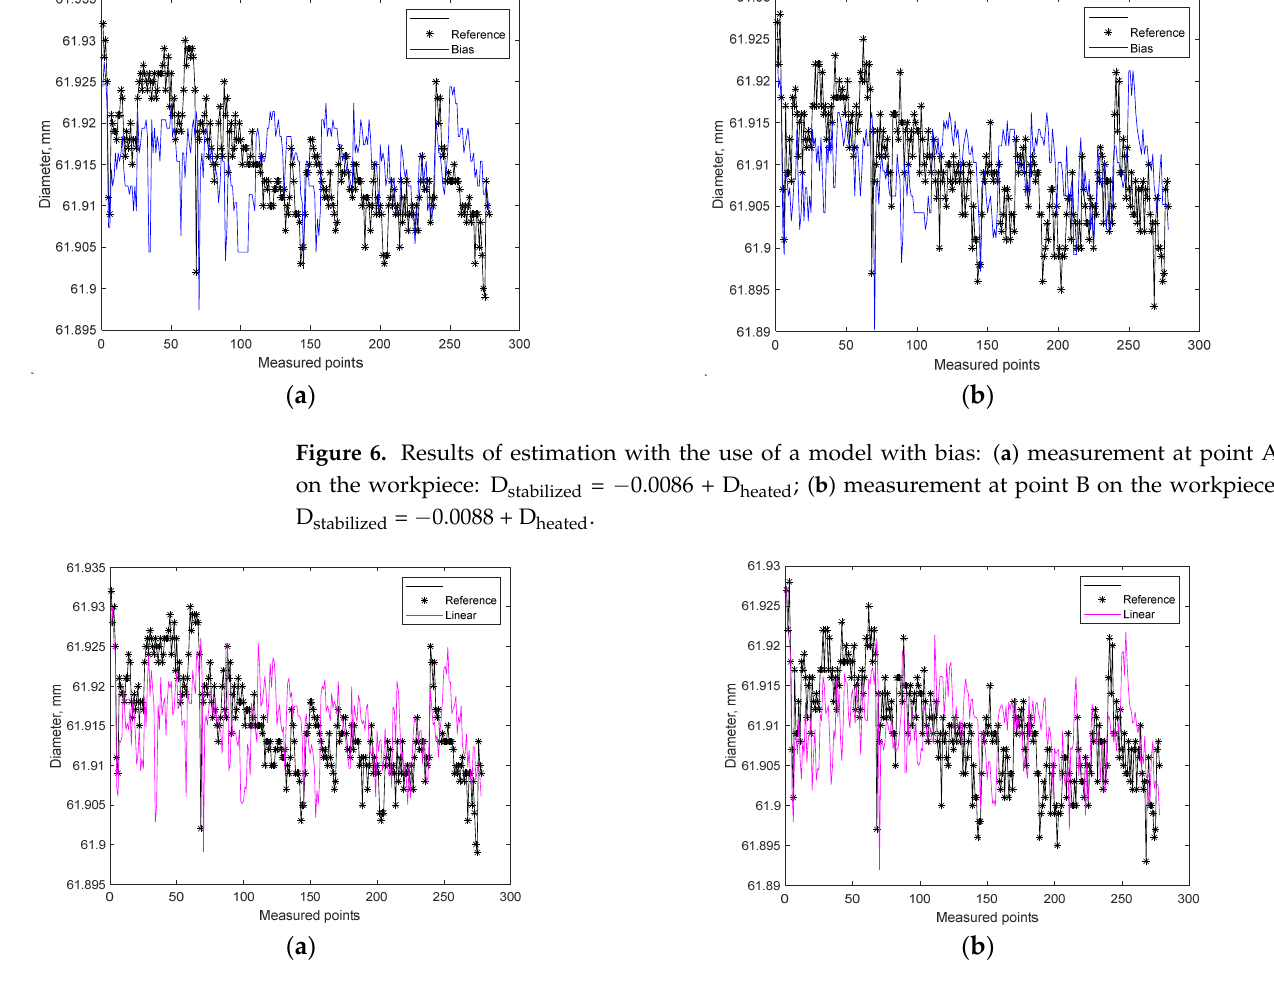
Figure 7. Results of estimation with the use of a linear model: ( a ) measurement at point A on the workpiece: D stabilized = − 0.0003 × temperature + 0.0133 + D heated ; ( b ) measurement at point B on the workpiece: D stabilized = − 0.0003 × temperature + 0.0135 + D heated .